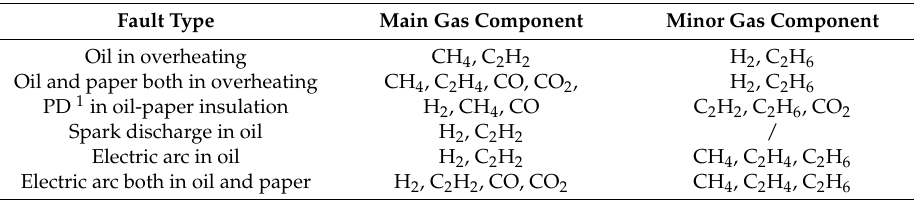
Table 2. The characteristic gases produced in different types of transformer faults.